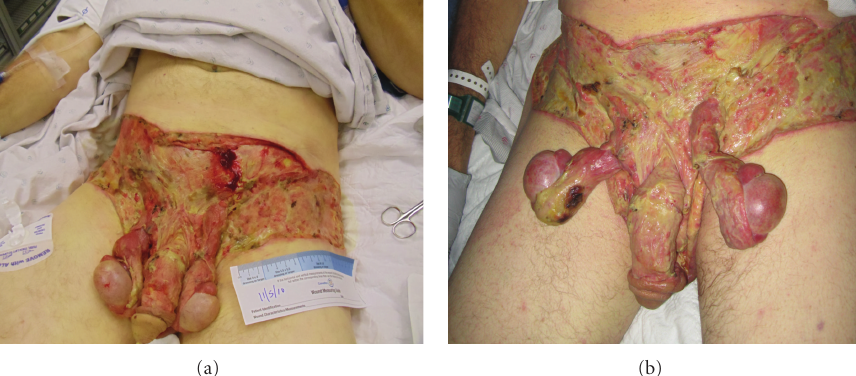
Figure 3: Fournier’s gangrene caused by Neisseria meningitidis : (a) the patient’s wound after three surgical debridements; (b) the same wound following two weeks of daily dressing, vacuum-assisted wound closure, and antibiotic regimen.